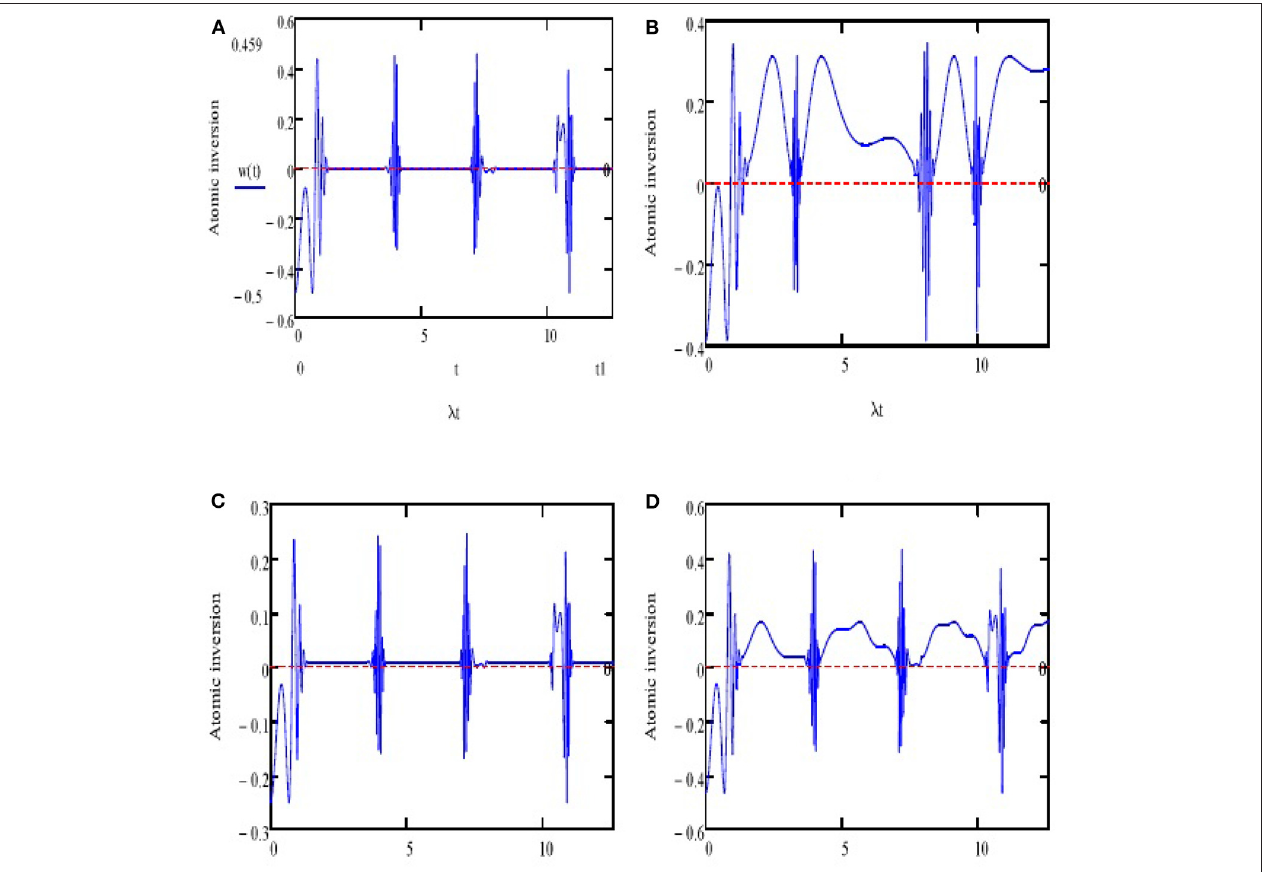
FIGURE 1 | W ( t ) for the parameters η = 25, φ = π/ 2 and 1 = 0.9, c = α = 1, β = 0.3. The atom is initially in the upper state c + = 0 in (A,B) and in a superposition state c + = 0.5 in (C,D) . The classical field effect is ignored λ 3 = 0 in (A,C) and is considered for λ 3 = 0.3 λ in (B,D) .